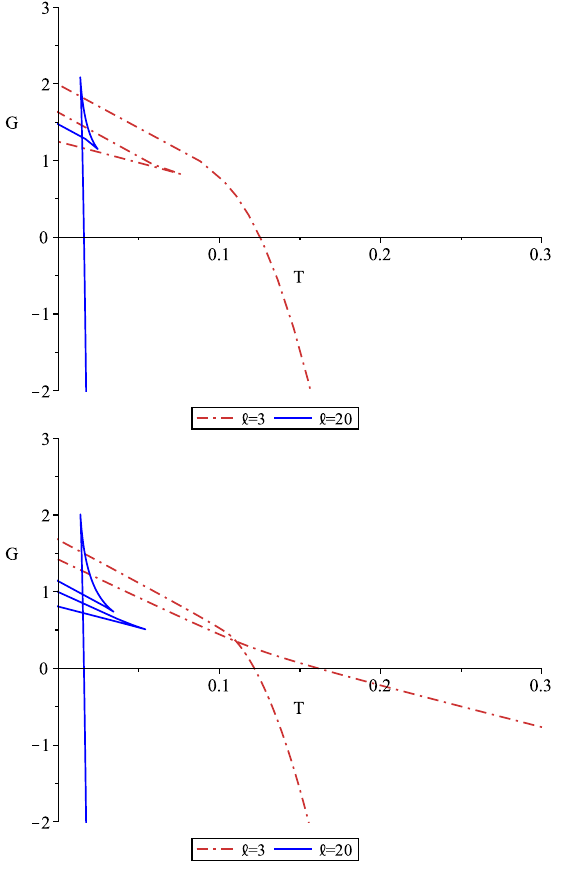
Figure 12 . Pressure Dependent Inverted Cusps. Blue solid curves correspond to ‘ = 20 (low pressure) and red dot-dash curves to ‘ = 3 (high pressure). Left: we set n = 1 . 3 , Q e = − 1 . 5 , and Q m = 1 . 1 . In this case there is only one extremal black hole at low pressure, but three extremal black holes at high pressure. Right: we set n = 1 . 3 , Q e = − 1 . 1 , and Q m = 0 . 964 . In this case there are three extremal black holes at low pressure, but only one extremal black hole at high